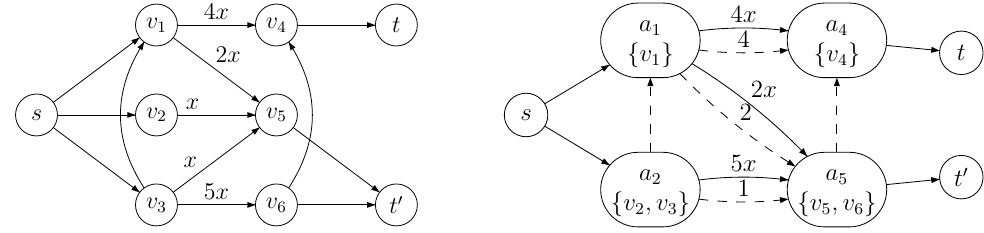
Figure 2. A CON-NG ( right ). Edges in E ↓ are solid. Edges in E ↑